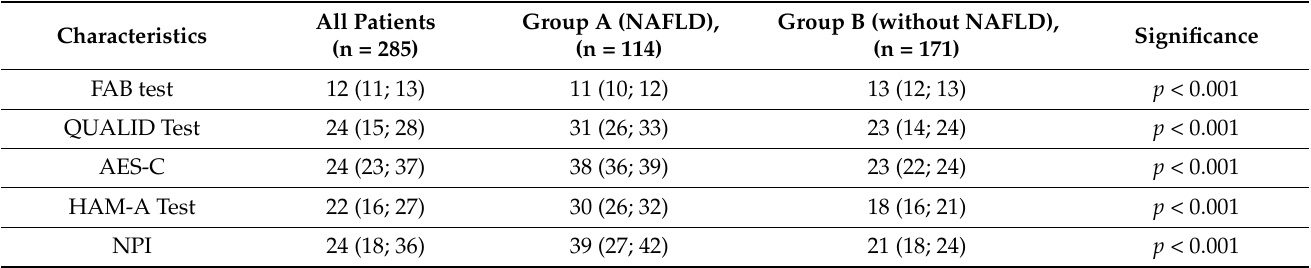
Table 2. Neuropsychological test characteristics of the enrolled population ( n = 285). Continuous variables are reported by median and interquartile ranges (IQR). Patients are stratified by presence ( n = 114) and absence ( n = 171) of NAFLD.